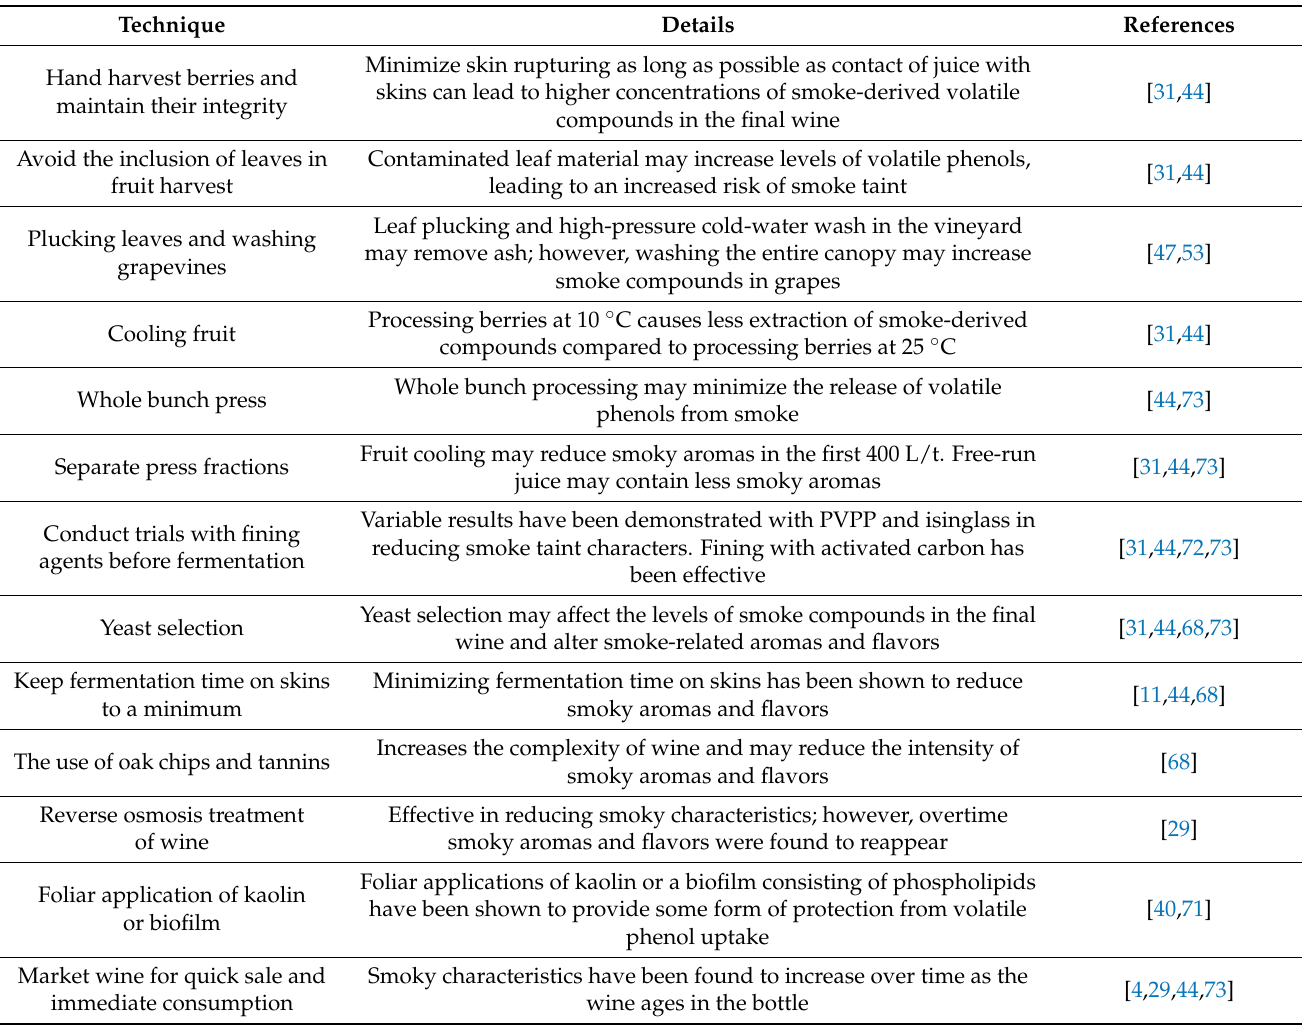
Table 4. Techniques for reducing smoke taint in